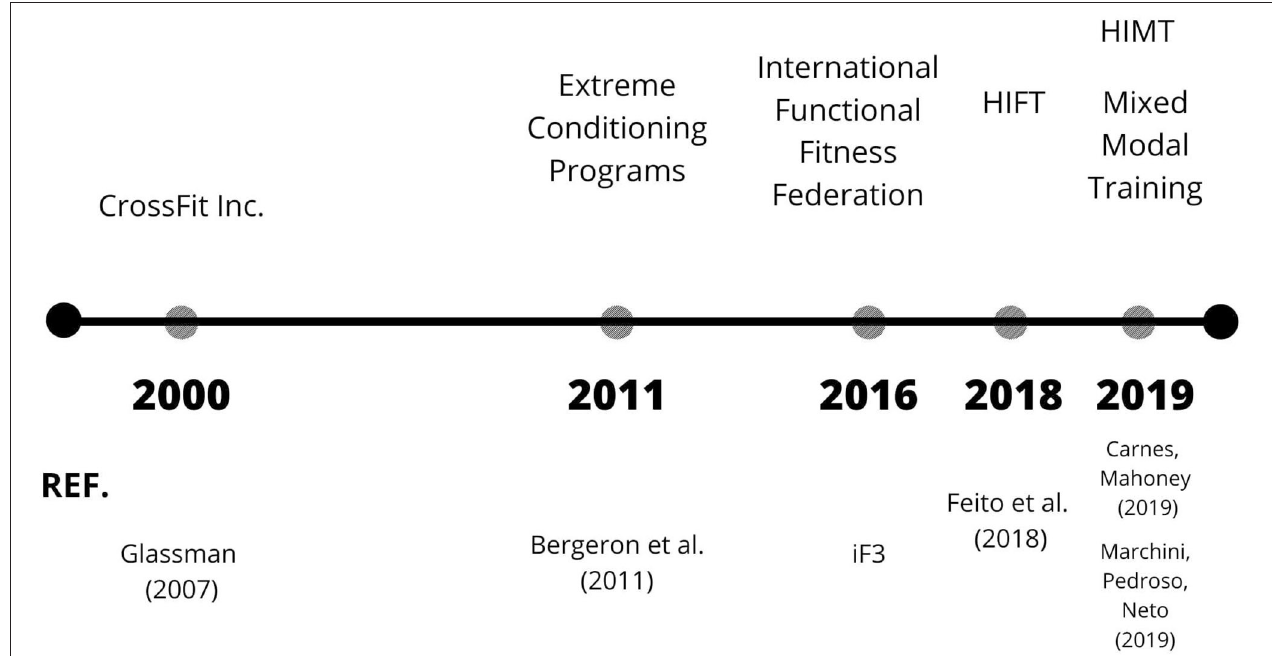
FIGURE 1 | Timeline of appearance of terms and